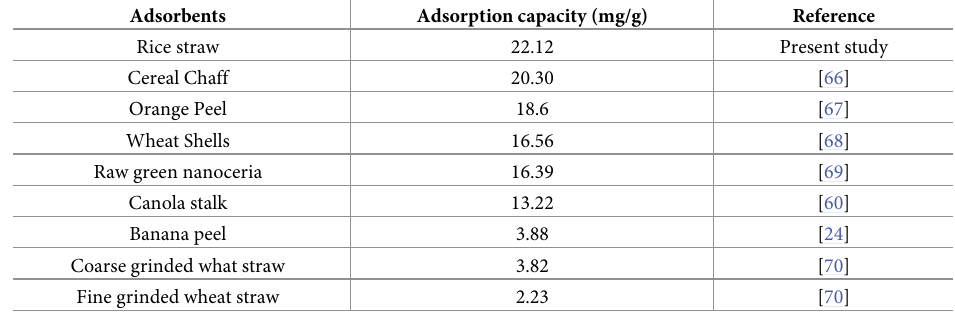
Table 4. Comparing the adsorption capacities of adsorbents obtained from agricultural waste and fruit/vegetable waste for separate dye